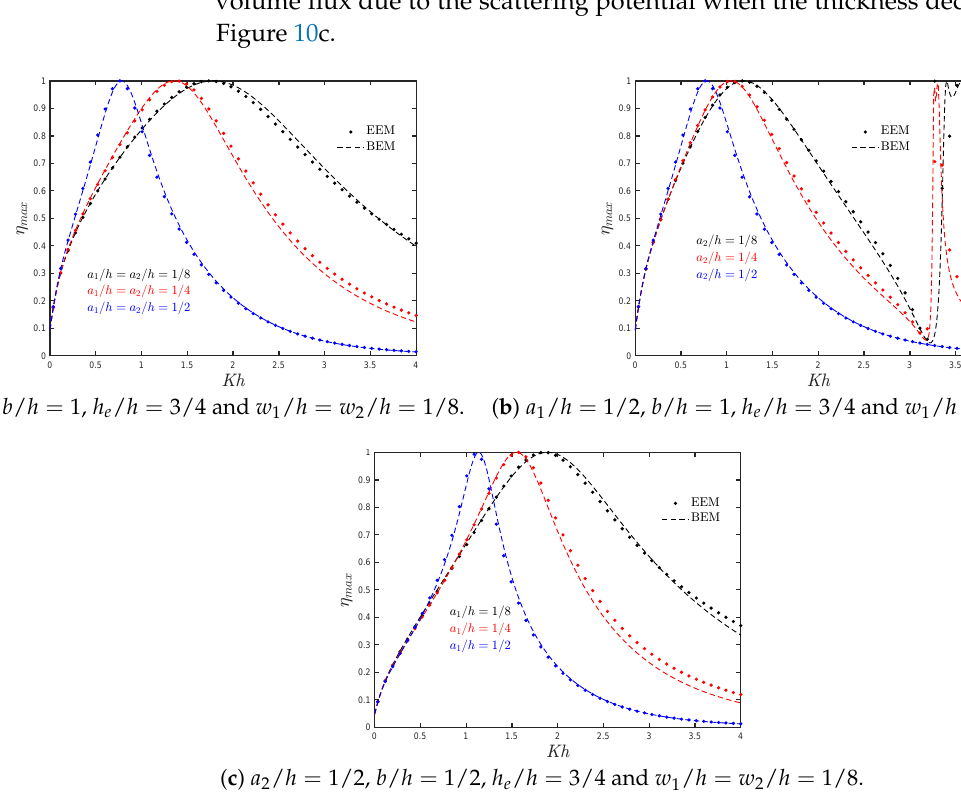
Figure 9. Maximum hydrodynamic efficiency η max versus the non-dimensional frequency Kh for different ( a ) submer- gence depths of the rear and front walls, a 1 / h and a 2 / h , respectively; ( b ) submergence depths of the front wall a 2 / h ; ( c ) submergence depths of the rear wall a 1 / h